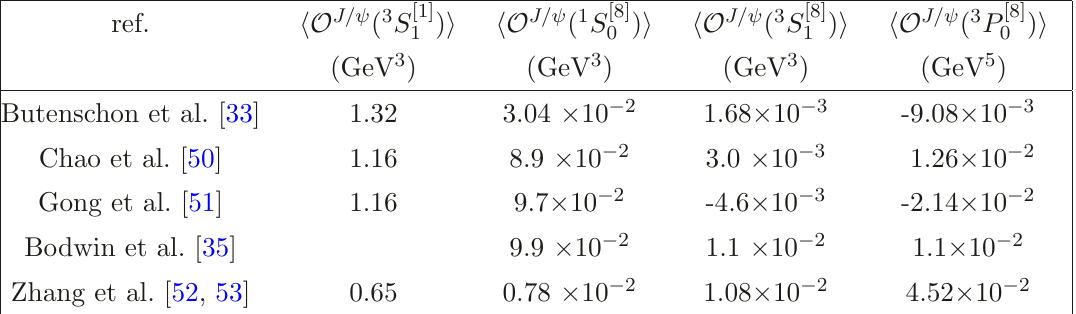
Table 1 . The values of the LDMEs for J/ψ production taken from refs. [33, 35,